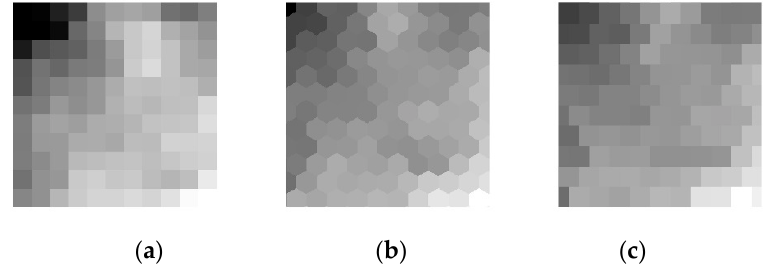
Figure 1. The images on three types of sensory arrangements. ( a ) The original square image (SQ); ( b ) hexagonal image (Hex_E); ( c ) half-pixel shift image (HS_E). ( b ) hexagonal image (Hex_E); ( c ) half-pixel shift image